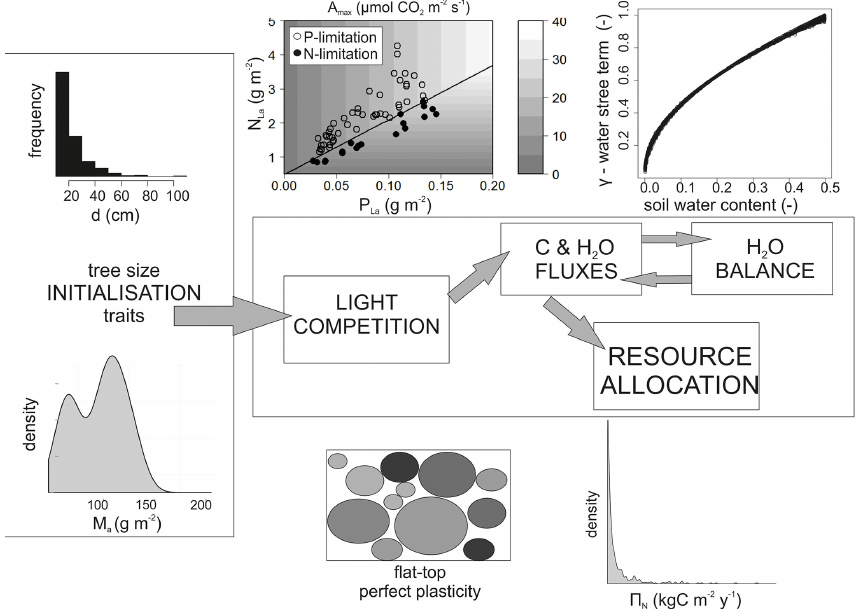
Figure 1. The five basic components of the model and information flow among them. Tree by tree traits and size initialisation takes place at the beginning of each simulation. Carbon and water fluxes, as well as gross and net primary productivity are estimated